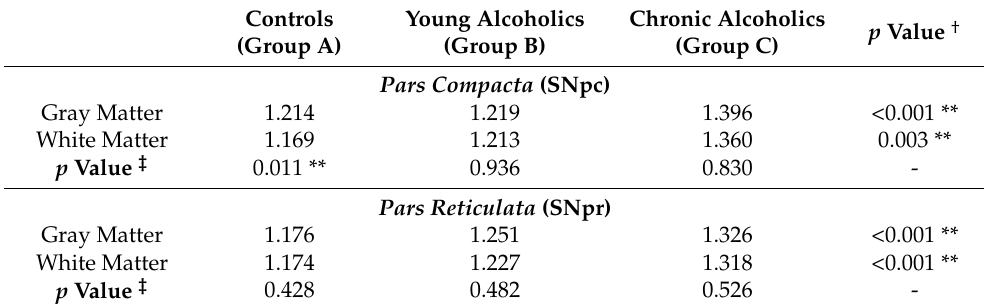
Table 6. Inter-group and intra-group comparisons of the differences in the grades of integrity of the BM based on the expression of laminin-111 in microvessels in the SN region (shown by weighted